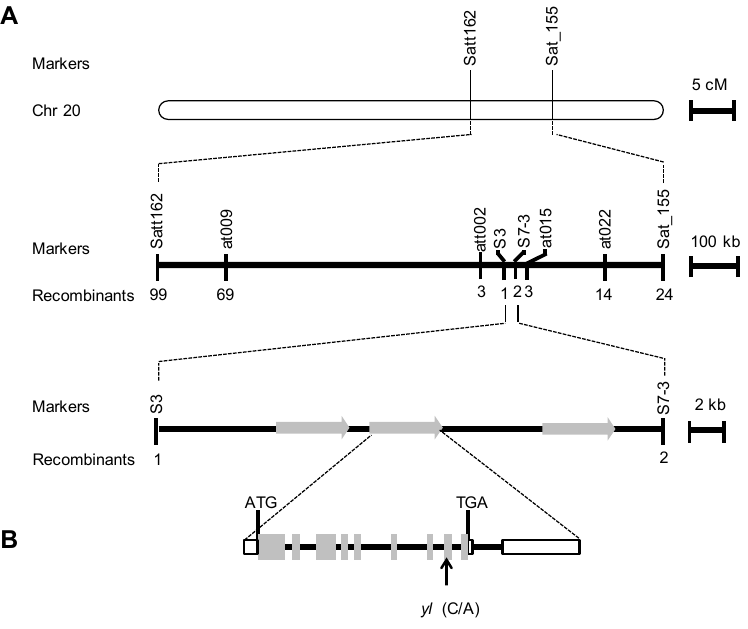
Figure 3. Fine mapping of the YL gene. ( A ) The YL locus was initially mapped to a region between markers Satt162 and Sat_155 on soybean chromosome 20. The gene was finally delimited to a 28 kb region between markers S3 and S7-3. Three predicted open reading frames (ORFs) were within this region. ( B ) YL ( Glyma.20G187000 ) structure indicating nine exons (gray boxes), eight introns (line segments between the exons), and 5 ′ and 3 ′ untranslated regions (white boxes with black frame). Start (ATG) and stop (TGA) codons are marked. The yl mutation in the YL gene is shown.